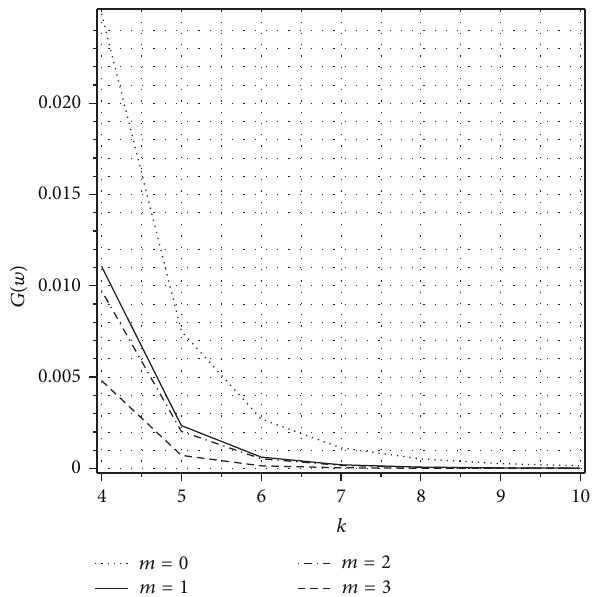
Figure 1: Artifact behavior of the 𝑞